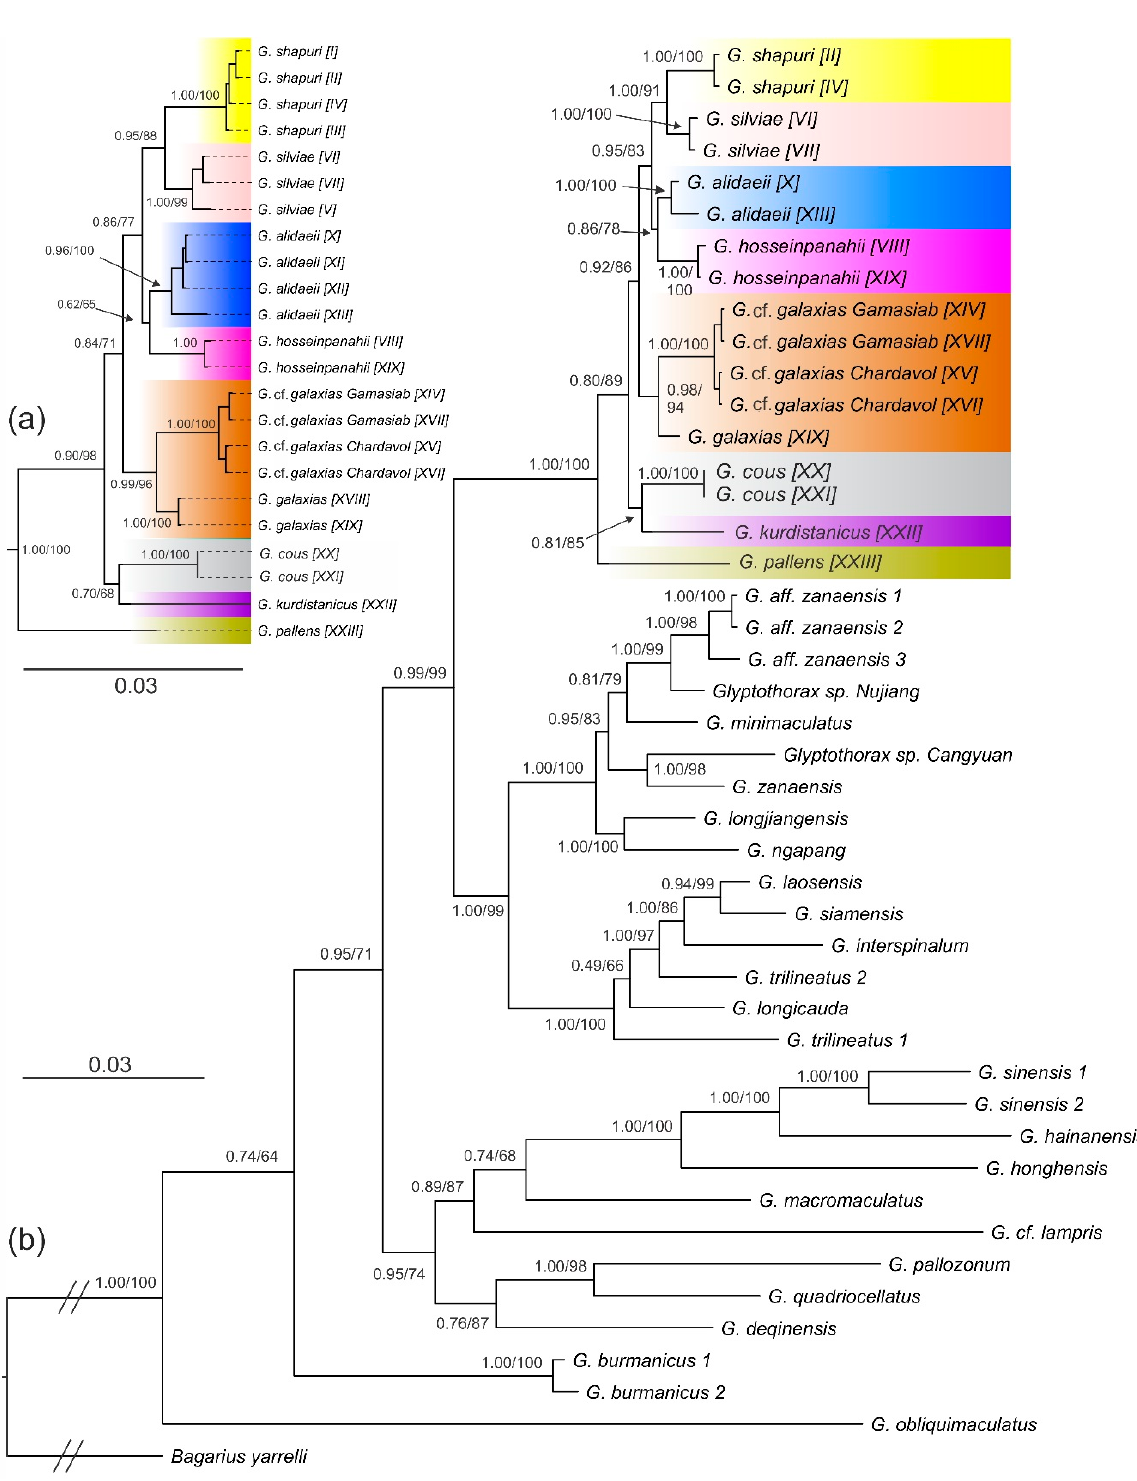
Figure 3. Phylogenetic relationships within Glyptothorax with focus on the Middle Eastern species, obtained from Bayesian (BI) and Maximum Likelihood (ML) analyses of combined COI+ Cyt b ( a ) and COI+ Cyt b+RAG2 ( b ) datasets. Support values given as Bayesian posterior probability/ML bootstrap (PP/BP). Greek numbers (I–XXIII) refer to the combined sequences from Table 1.